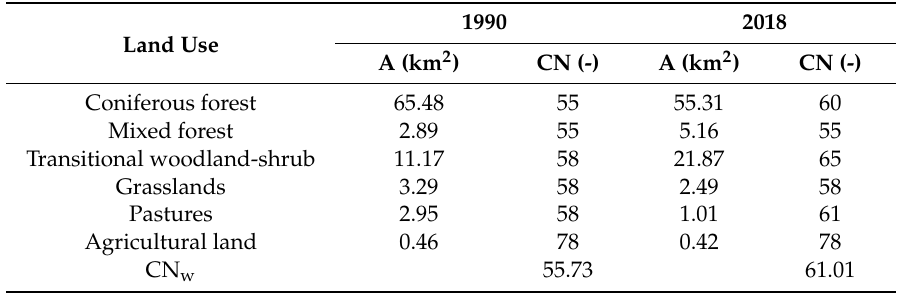
Table 9. The selected values of the CN parameter for the Ipoltica River Basin (A–area; CN–Curve Number value; CN w –weighted CN value).